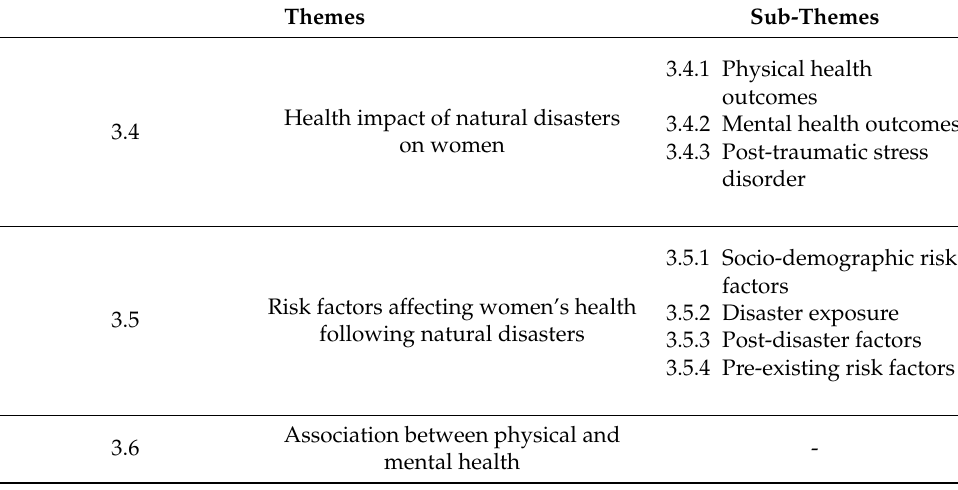
Table 4. Schematic of